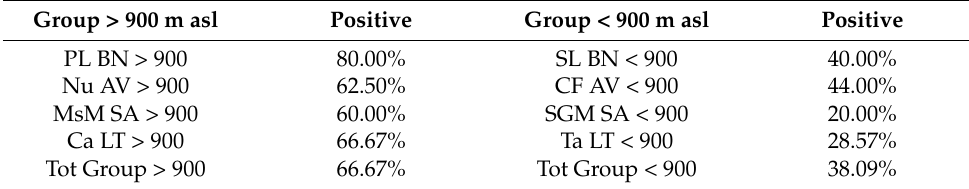
Table 3. Percentages of positive samples according to sampling area.